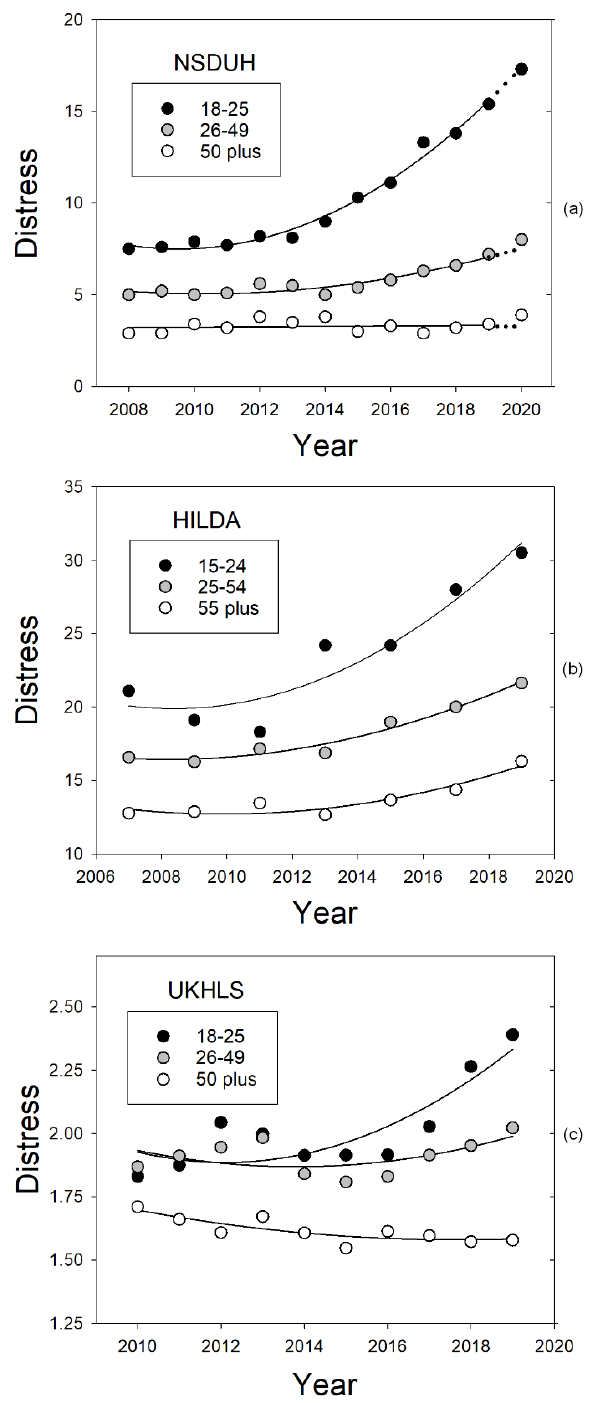
Figure 1. Changes in psychological distress across the years prior to the COVID-19 pandemic. Solid curves represent the quadratic functions that best fit the data through 2019 for the three age groups in each panel. Note that both axes vary slightly depending on the survey and that, whereas panel ( a ) and panel ( b ) present percentages experiencing serious distress, panel ( c ) presents mean scores on the GHQ-12. The dotted lines shown in the upper panel represent the predictions of the functions that best described distress in the US from 2008 to 2019 for each age group. (The predictions for the UK based on their national survey, the UKHLS, are not depicted here.)